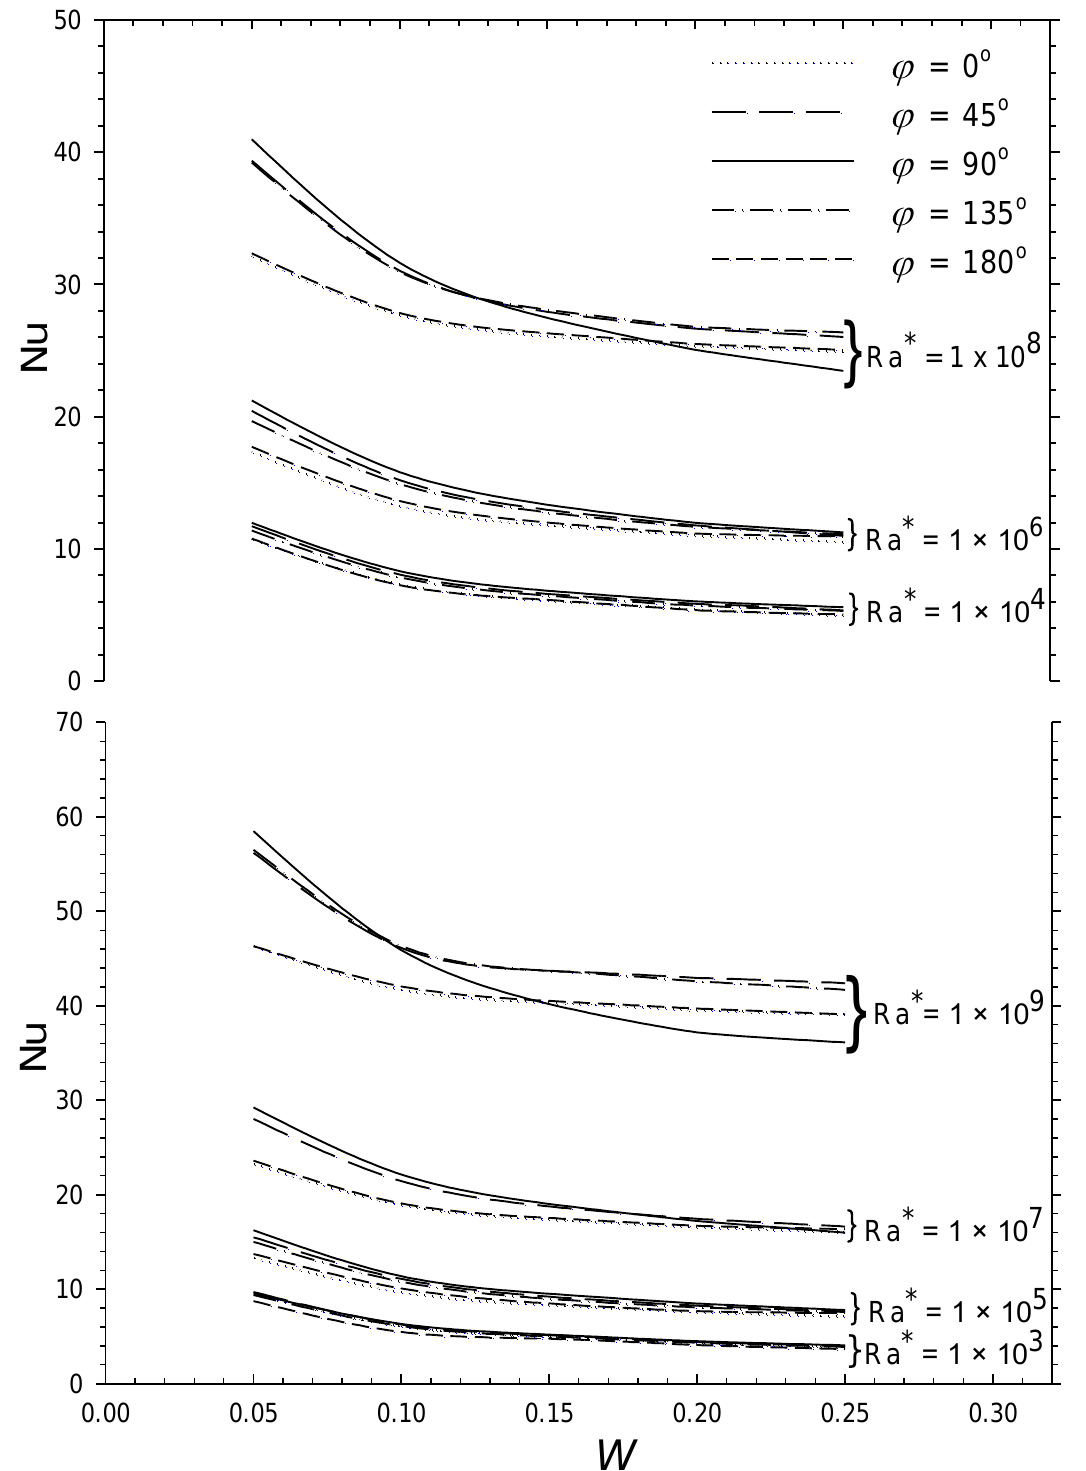
Figure 5. Variations in mean Nusselt number with dimensionless width, W , for different values of the Rayleigh number, Ra, and positions, ϕ , for all surfaces of the slender cuboid.